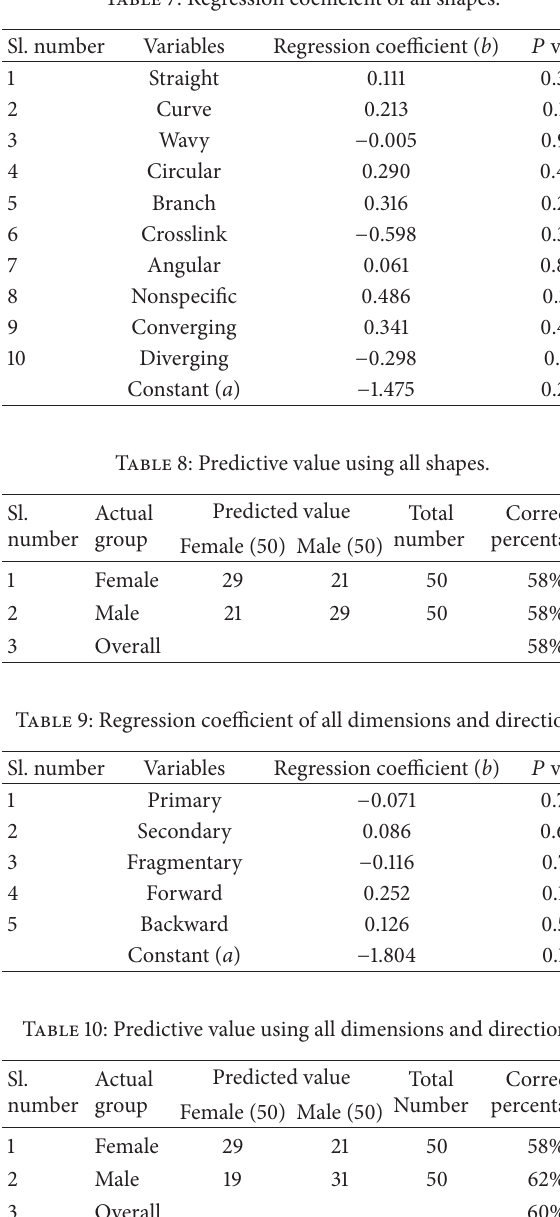
Table 7: Regression coefficient of all shapes.